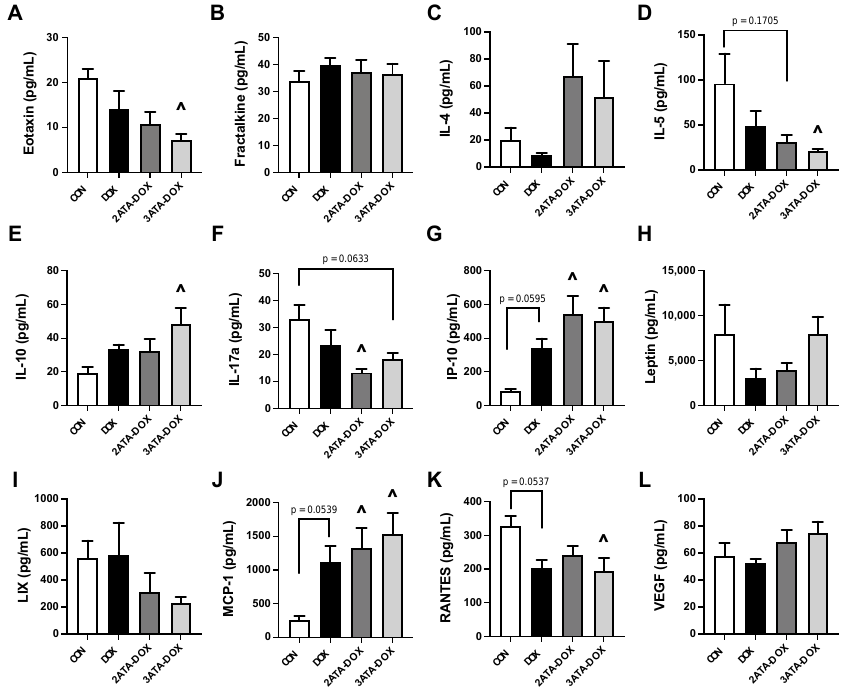
Figure 7 . Circulating Cytokines/Chemokines . Plasma levels of ( A ) eotaxin; ( B ) fractalkine; ( C ) inter- Figure 7. Circulating Cytokines/Chemokines. Plasma levels of ( A ) eotaxin; ( B ) leukin-4 (IL-4); ( D ) interleukin-5 (IL-5); ( E ) interleukin-10 (IL-10); ( F ) interleukin-17a (IL-17a); ( G ) interferon gamma-induced protein 10 (IP-10 or CXCL10); ( H ) leptin; ( I ) C-X-C motif chemokine 5 (CXCL5 or LIX); ( J ) monocyte chemoattractant protein-1 (MCP-1/CCL2); ( K ) regulated upon activa- tion, normal T cell expressed and presumably secreted (RANTES); and ( L ) vascular endothelial growth factor (VEGF). ( p < 0.05). Values are represented as means ± SEM. ^ = significantly different vs. CON ( p < 0.05).